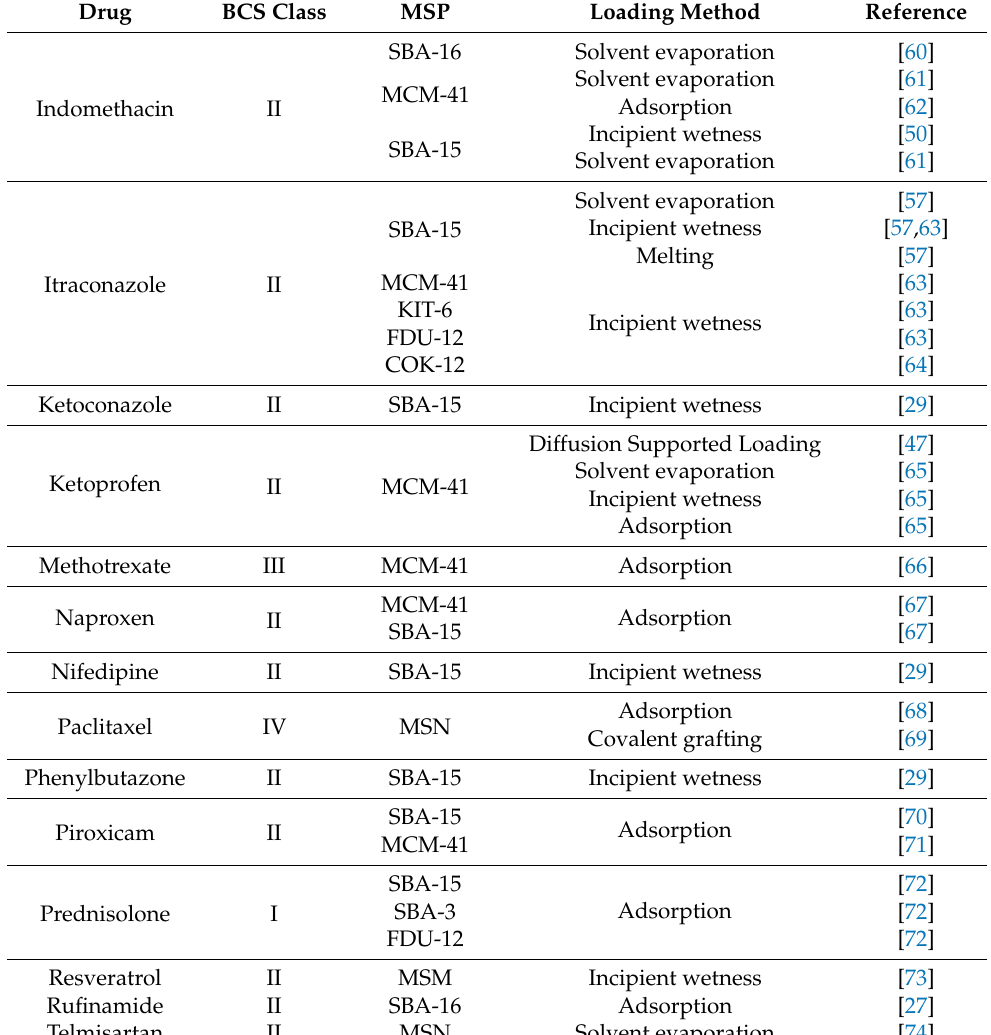
The table is a compilation and extension of data published by Maleki et al. [20]; BCS—Biopharmaceutics Classification System; COK—Center for Research Chemistry and Catalysis; MSM—mesoporous silica